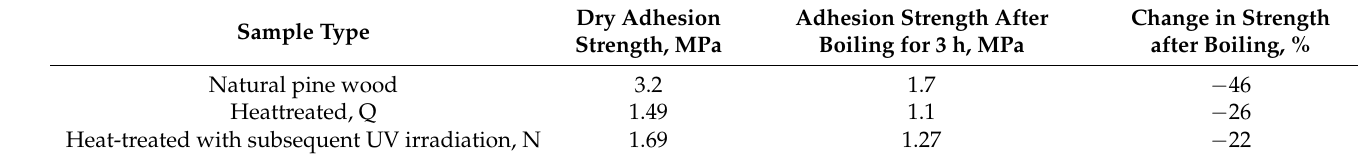
Table 2. Sample adhesion